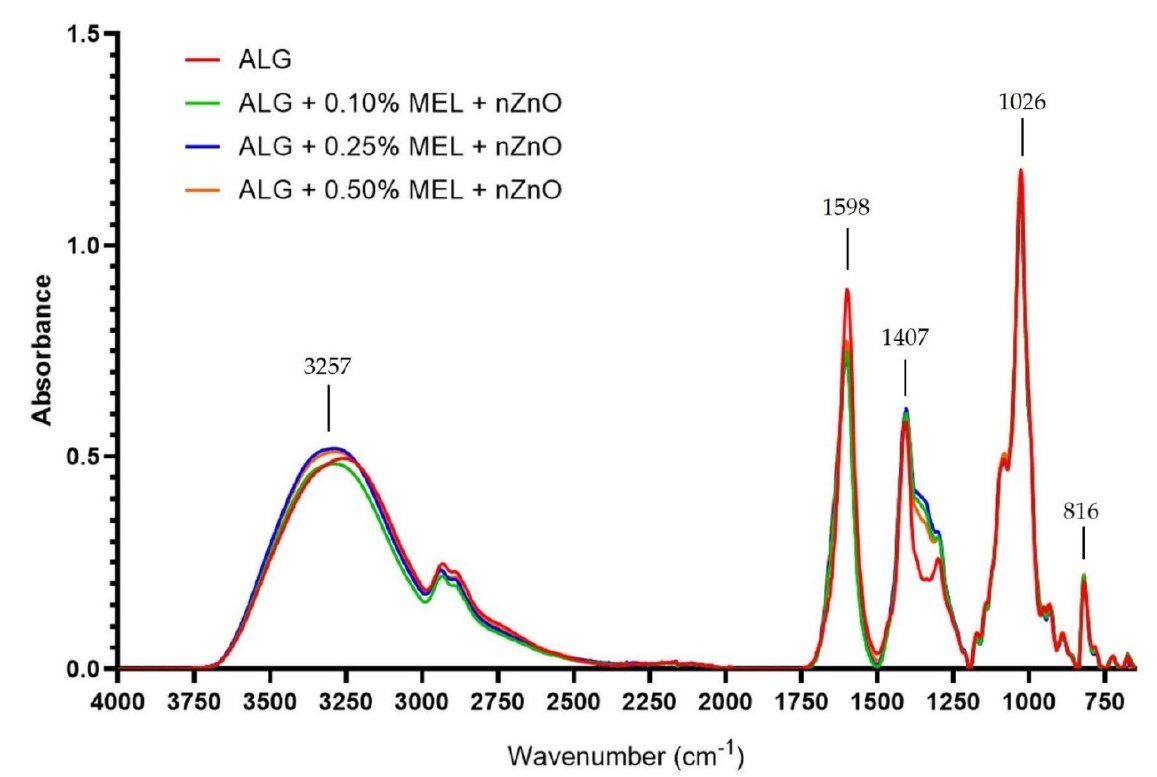
Figure 7. FT-IR spectra of unmodified and modified with melanin and zinc oxide nanoparticles alginate films.